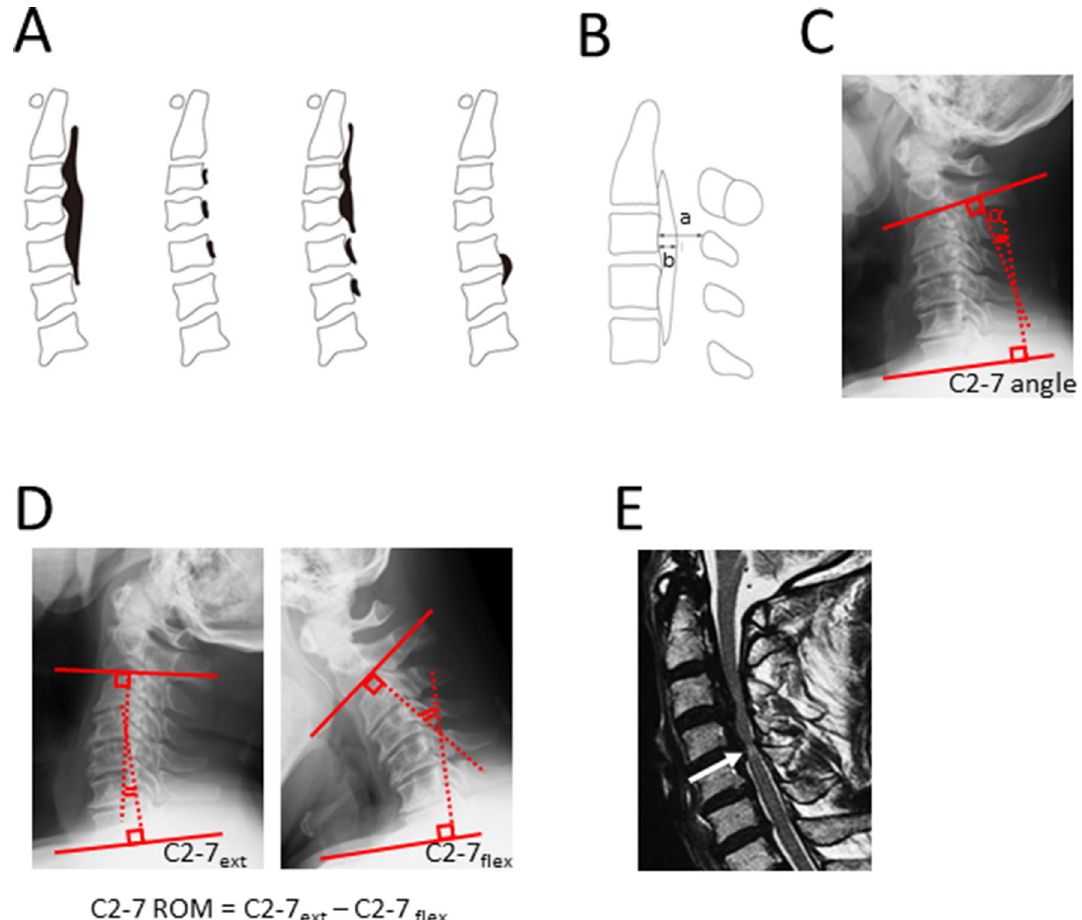
Figure 1. Methods for imaging analyses. ( A ) OPLL was classified into 4 types (continuous, segmental, mixed and localized types). ( B ) Canal narrowing rate was calculated as followings, thickness of OPLL at peak (b)/ antero-posterior diameter (a), in lateral radiogram of cervical spine in neutral position. ( C ) C2-7 angle was measured as angle between inferior endplates of C2 and C7 vertebral bodies ( C ). Lordosis curve was expressed as positive value and kyphosis curve was expressed as negative value. Post-operative change of C2-7 angle was calculated as subtraction of postoperative C2-7 angle from preoperative C2-7 angle. ( D ) C2-7 range of motion (ROM) was calculated as subtraction of C2-7 angle from extension position to flexion position ( D ), and change of C2-7 range of motion was calculated as (preoperative C2-7 ROM)—(postoperative C2-7 ROM)). ( D ) Spinal cord signal intensity change in magnetic resonance imaging (MRI) T2 weighted image were assessed because the intramedullary signal change had been reported as one of the imaging factors for prediction of surgical outcome ( E ,